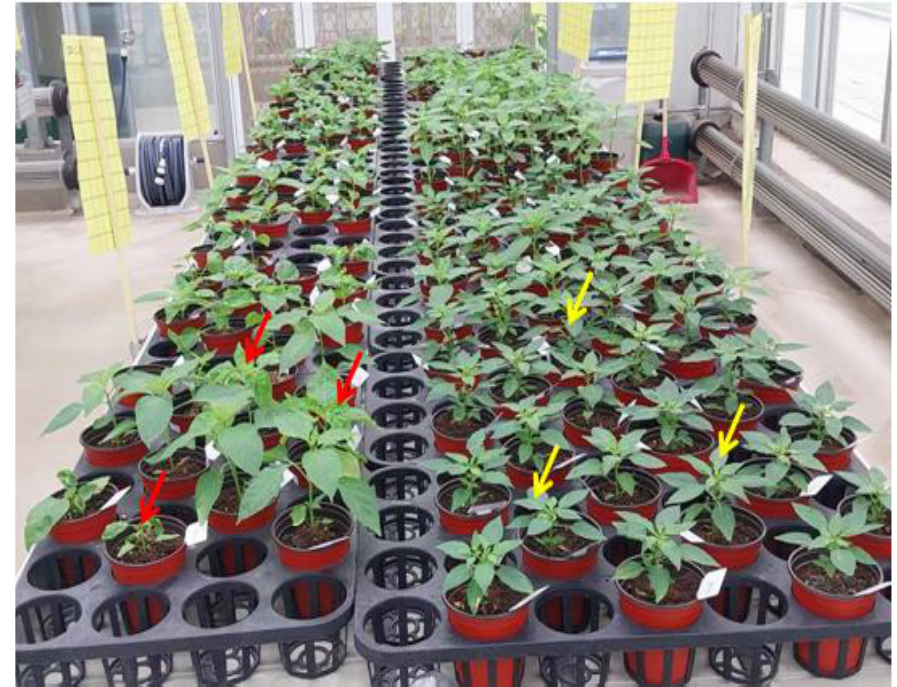
Figure 4. Mechanical inoculation of pepper germplasm with PMMoV pathogen under greenhouse conditions. Red and yellow arrows indicate plants of susceptible and resistant accessions, respectively. The photographs were taken 14 days postinoculation (DPI) during greenhouse experimental screening. Table 4. Pepper genetic resources with resistance against PMMoVpathotypes.